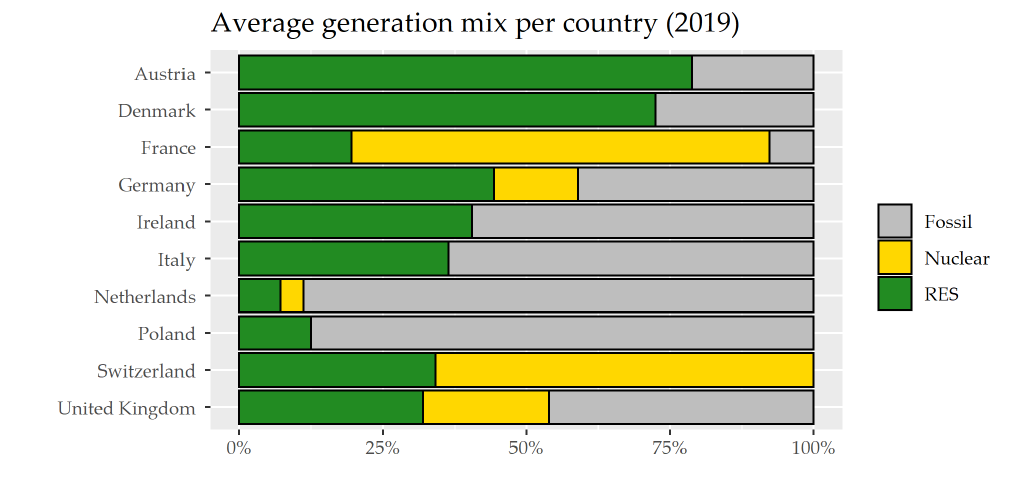
Figure 2. Average electricity mixes in 2019 on an annual basis in different European